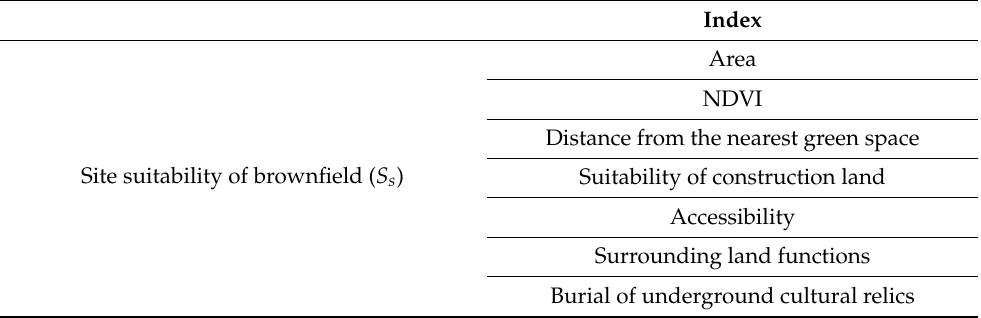
Table A1. Index system of site suitability of brownfield ( S s ).